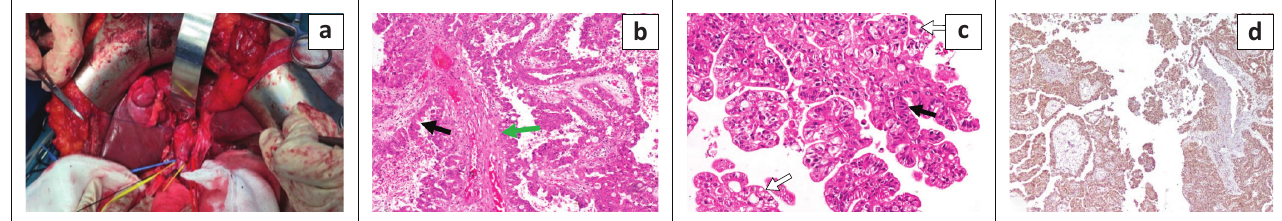
FIGURE 5: (a) The patient underwent open hilar resection with standard lymphadenectomy and right and left Roux-en-Y-cholangiojejunostomy. Papillary growth was seen at the primary confluence, extending into the right hepatic duct. (b) Low–power photomicrograph (Hematoxylin & eosin [H & E] stain; magnification 10×) of the resected specimen showing papillary projections (black arrow) with a central fibrovascular core (green arrow). (c) High-power photomicrograph (H & E stain; magnification- 20×) showing irregular papillae with features of high-grade dysplasia and hyperchromatic nuclei (black arrow); goblet cells are also seen (white arrow). (d) Positive immunohistochemistry staining (brown) for MUC2 and MUC5 using recombinant